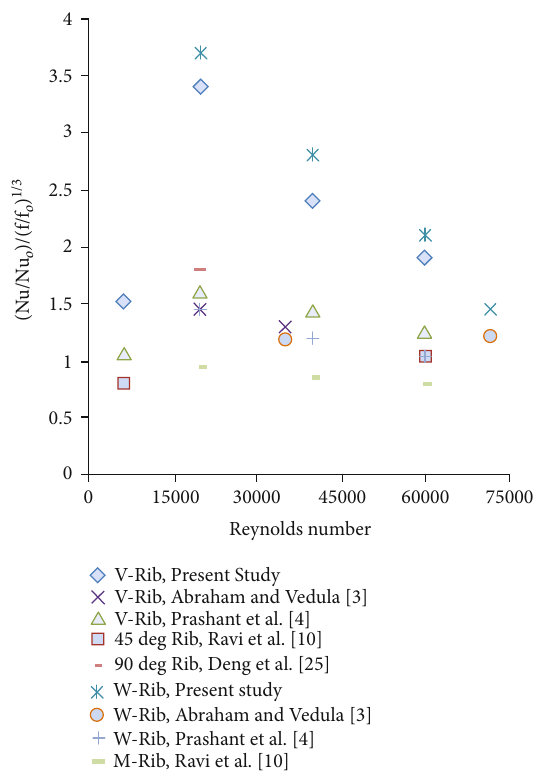
Figure 13: Comparison of THP with published